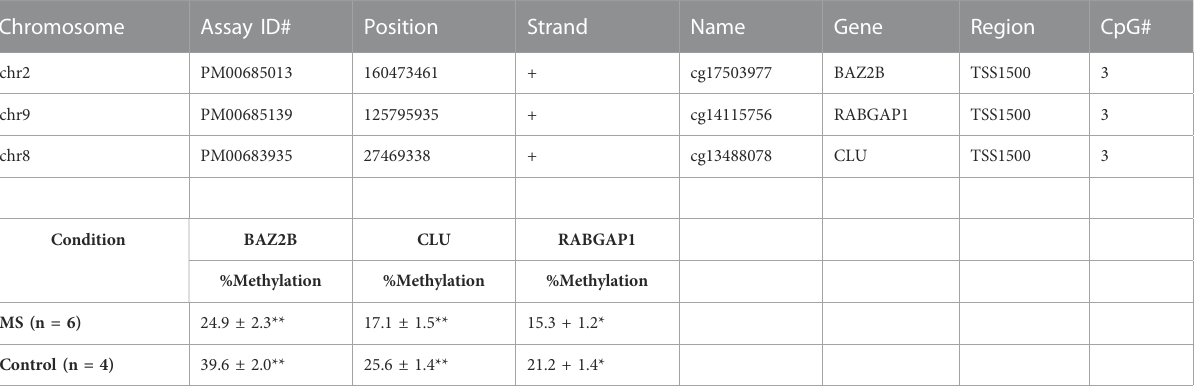
TABLE 6 Pyrosequencing